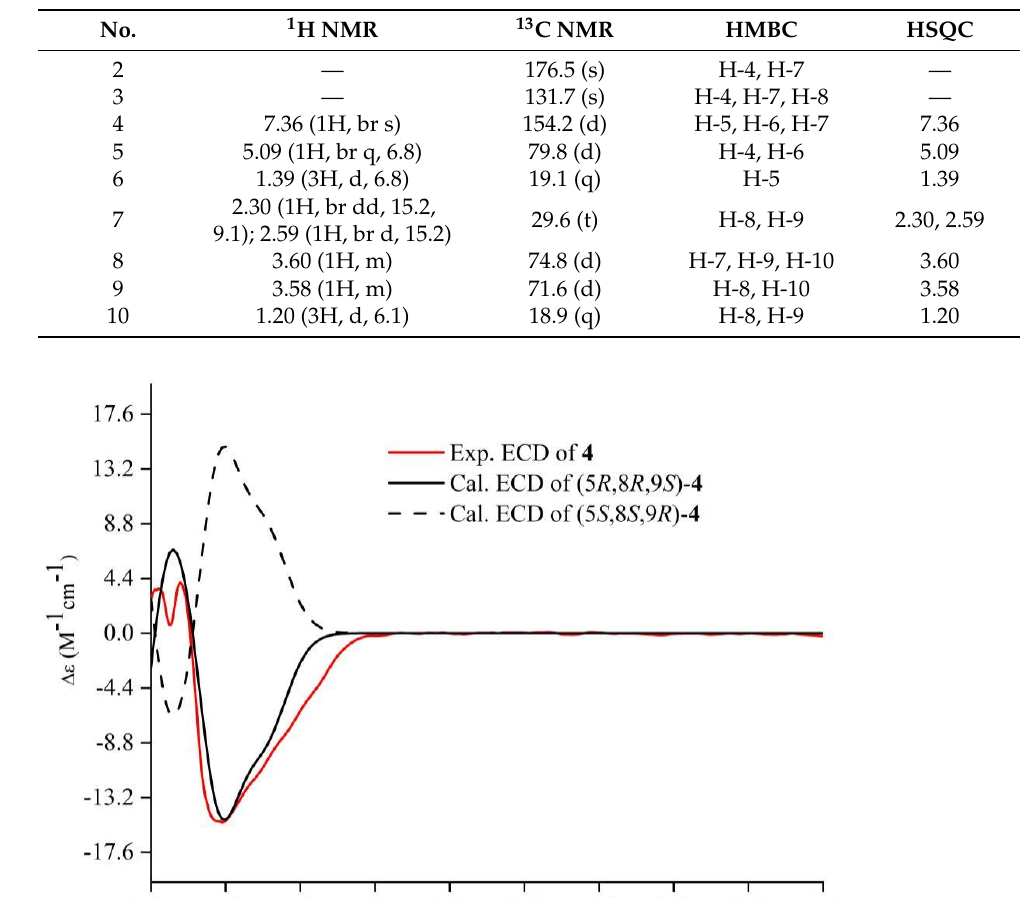
Table 1. The 1 H, 13 C, HMBC, and HSQC NMR data for compound 4 in CD 3 OD.